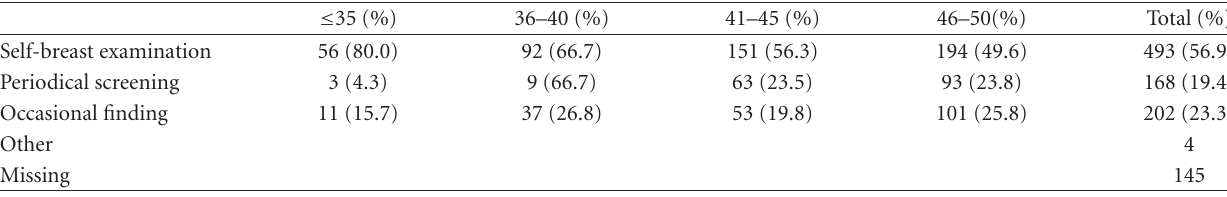
Table 2: Diagnosis of breast cancer— n (%).